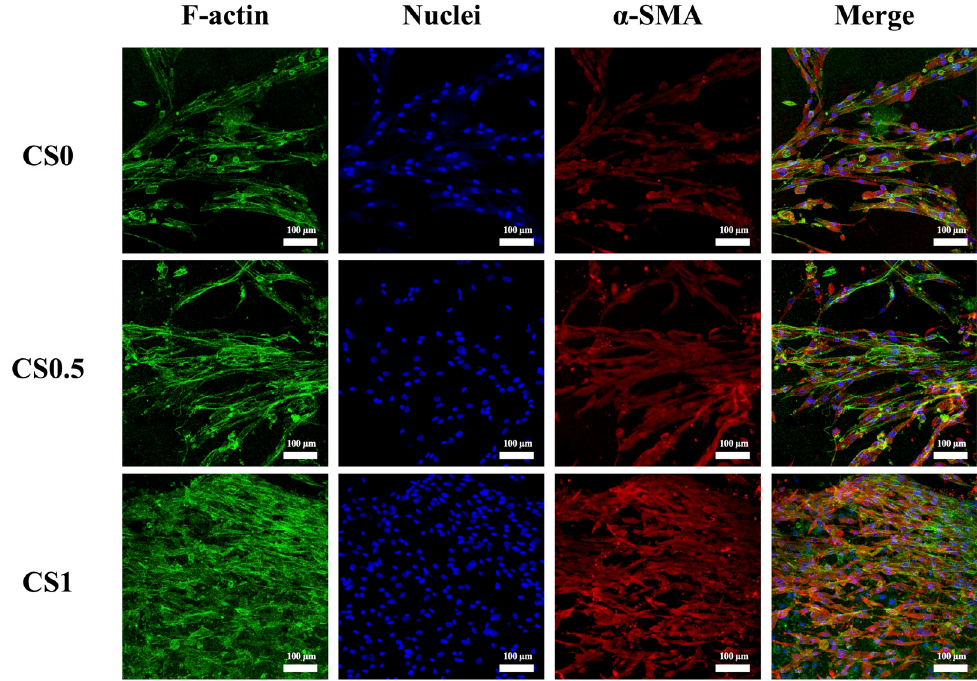
Figure 8. Immunofluorescence staining of α -SMA expression of hPDLs-laden various CS-contained FgelMa auxetic scaffolds with cyclic tensile stimulation for 3 days. Immunofluorescence images showed localization of F-actin, nucleus, and α -SMA on day 3 (green: F-actin; blue: nucleus; red: α -SMA; scale bar is 100 μ m).